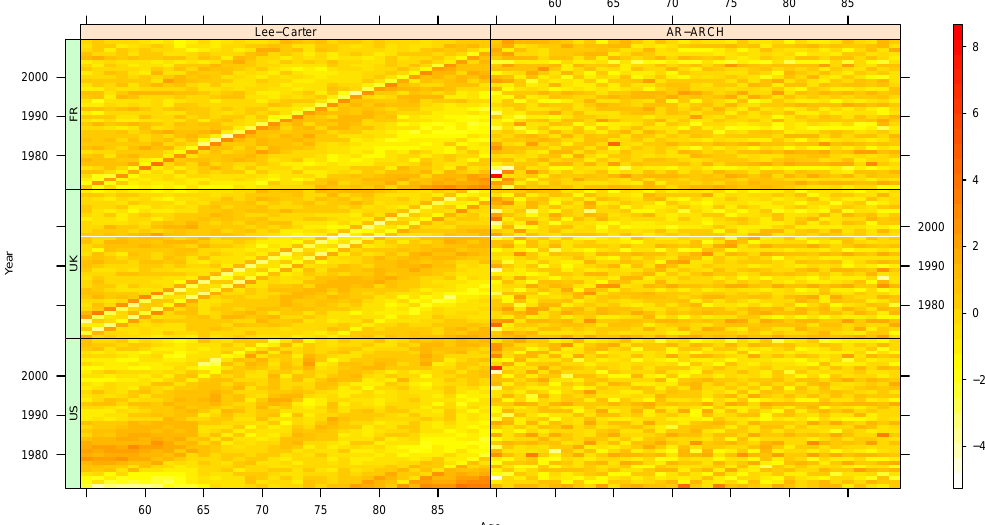
Figure 5. Standardized residuals: Heatmaps for the standardized residuals produced by the Lee– Carter ( left panel) and the selected AR-ARCH model ( right panel) for the French, England and Wales, and United States male